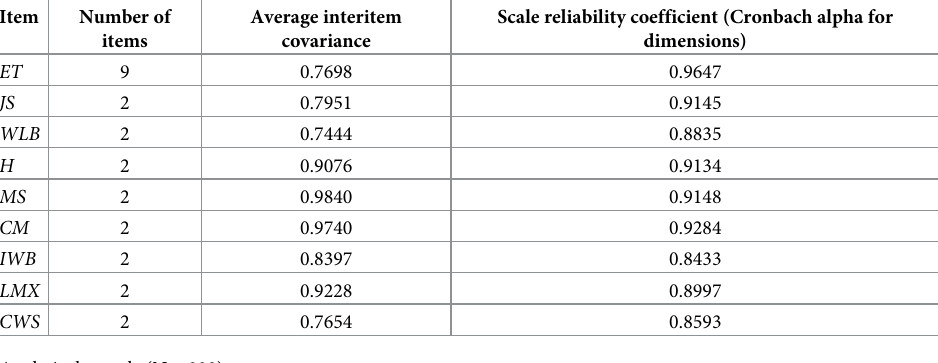
Table 3. Internal consistency.